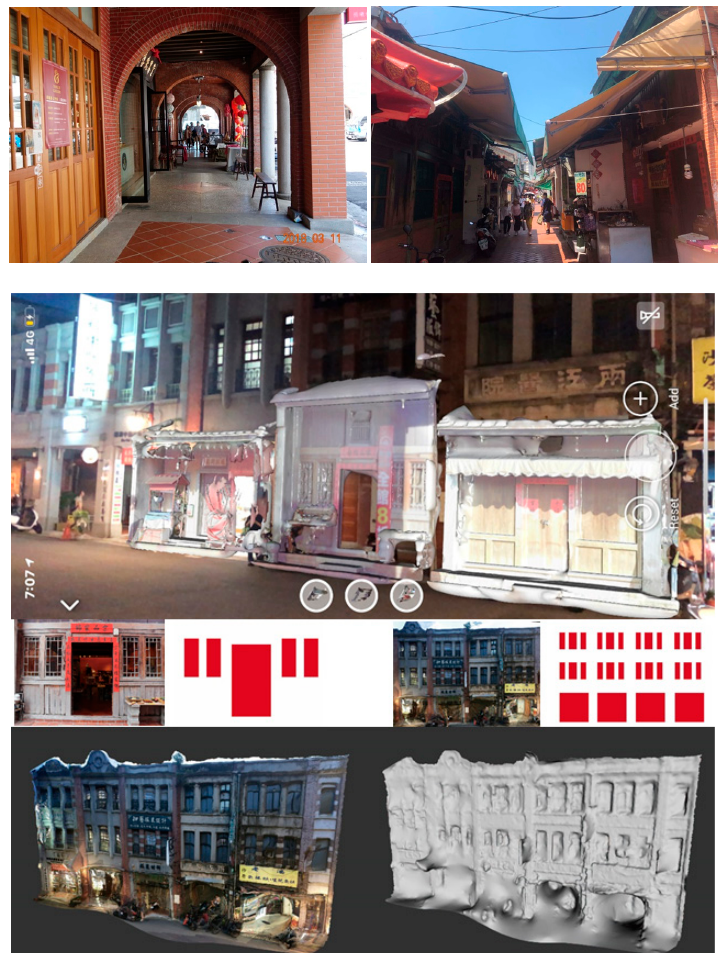
Figure 15. The pedestrian arcade with/out a recessed setting ( top ), three façades applied to recessed setting in Dihua Street ( upper middle ), comparison of the different opening composition on an old ground floor on Lukang Old Street and a new three-story high construction on Dihua Street at a remote site ( lower middle ), and the original 3D façades model of Dihua Street ( bottom ).